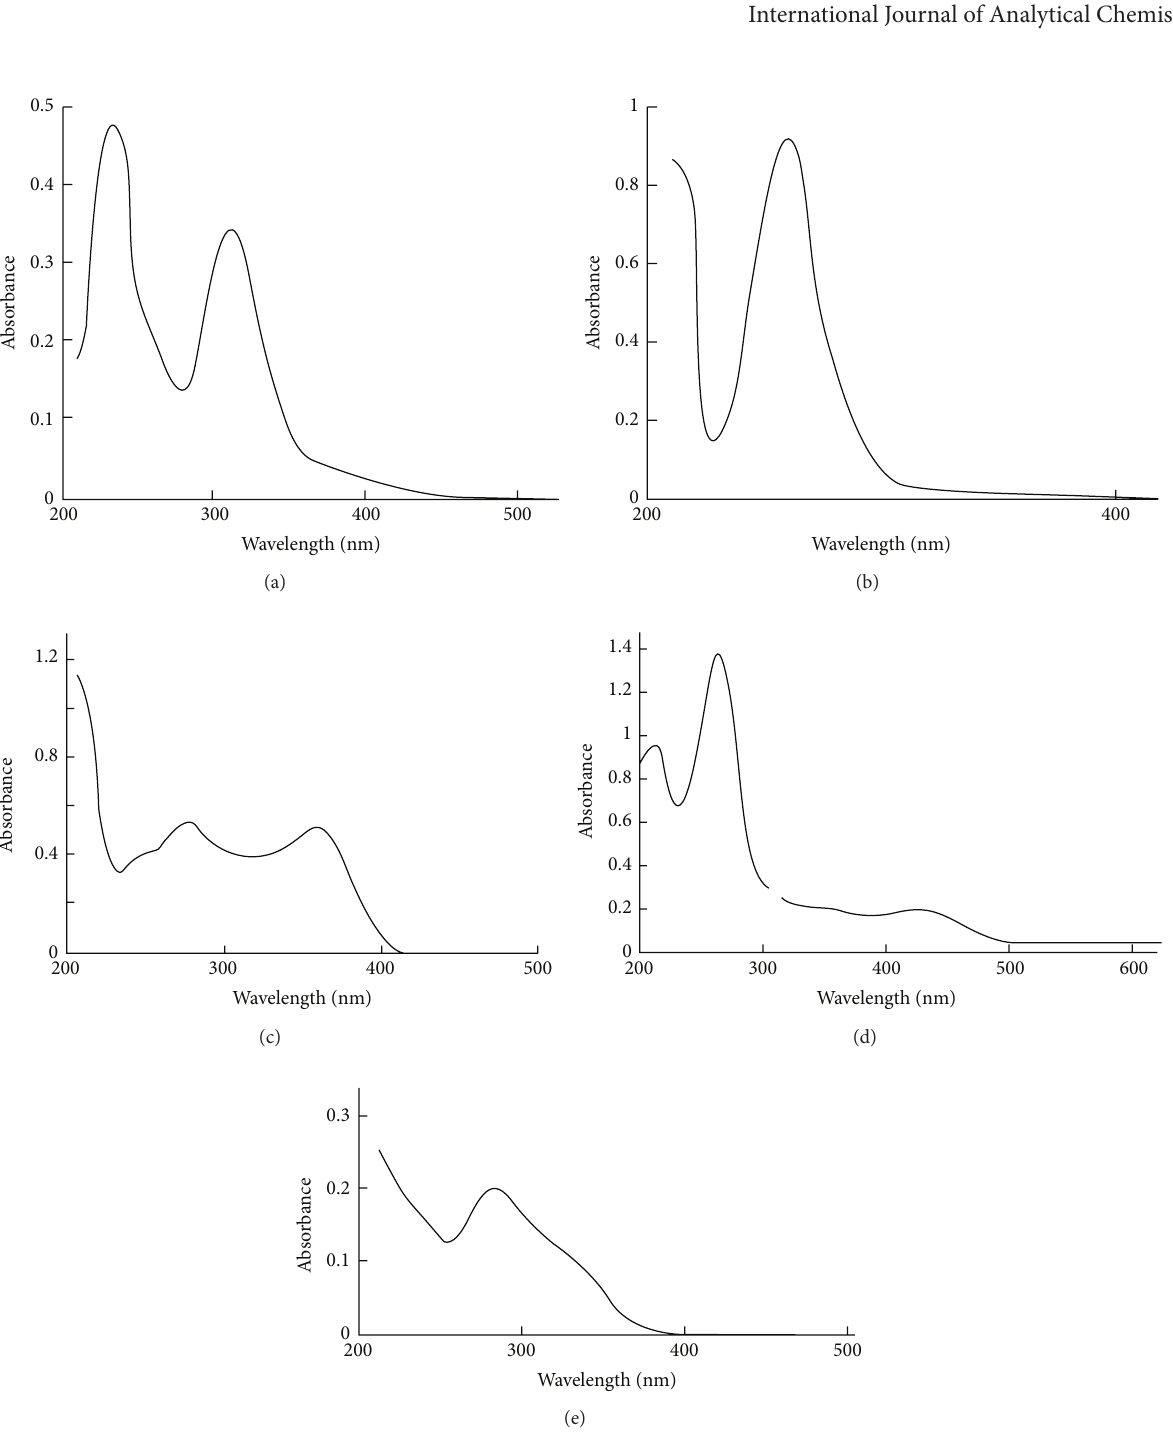
Figure 2: UV-visible spectra of (a) gold(III) ion, (b) mercury(II) ion, (c) TC. HCl, (d) TC-Au(III), and (e) TC-Hg(II) complexes in aqueous solutions (50 𝜇 g/mL each).